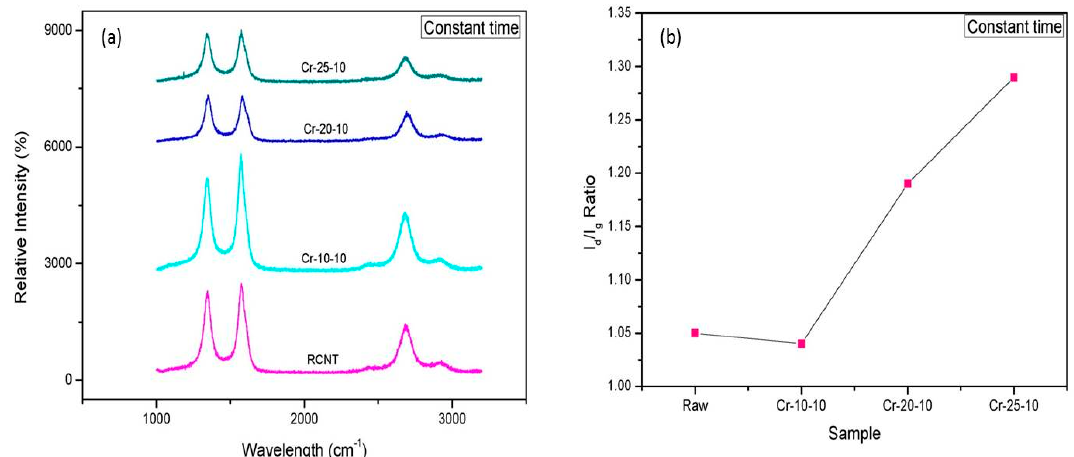
Figure 4. ( a ) Raman spectra; and ( b ) I d / I g ratios of RCNT, Cr-10-10, Cr-20-10, and Cr-25-10. The I d / I